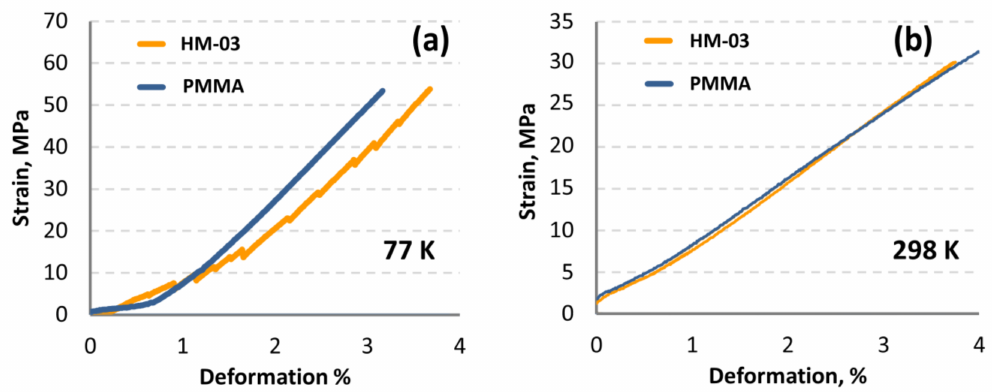
Figure 9. Stress–strain test of nominally pure PMMA and Gd-doped PMMA (HM-03) at room ( a ) and liquid nitrogen ( b )